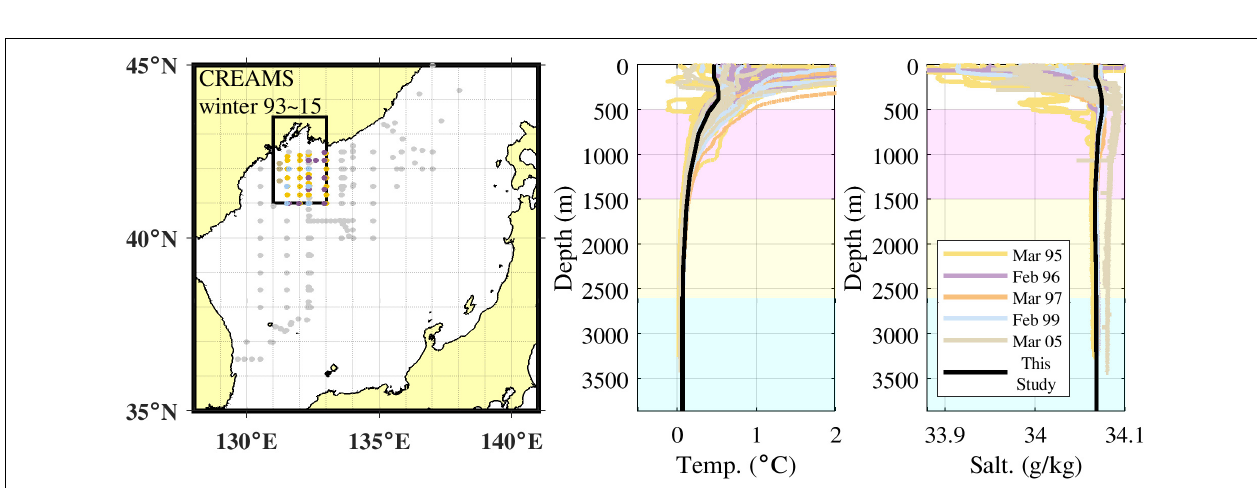
FIGURE 1 | (Left panel) Sea surface temperature from satellite observation (OSTIA) in February 2001. (Right panel) Study area, including the continental shelf and slope south of Vladivostok. White solid lines represent isobaths. The model was idealized to mimic the actual topography inside the red rectangle in the right panel.